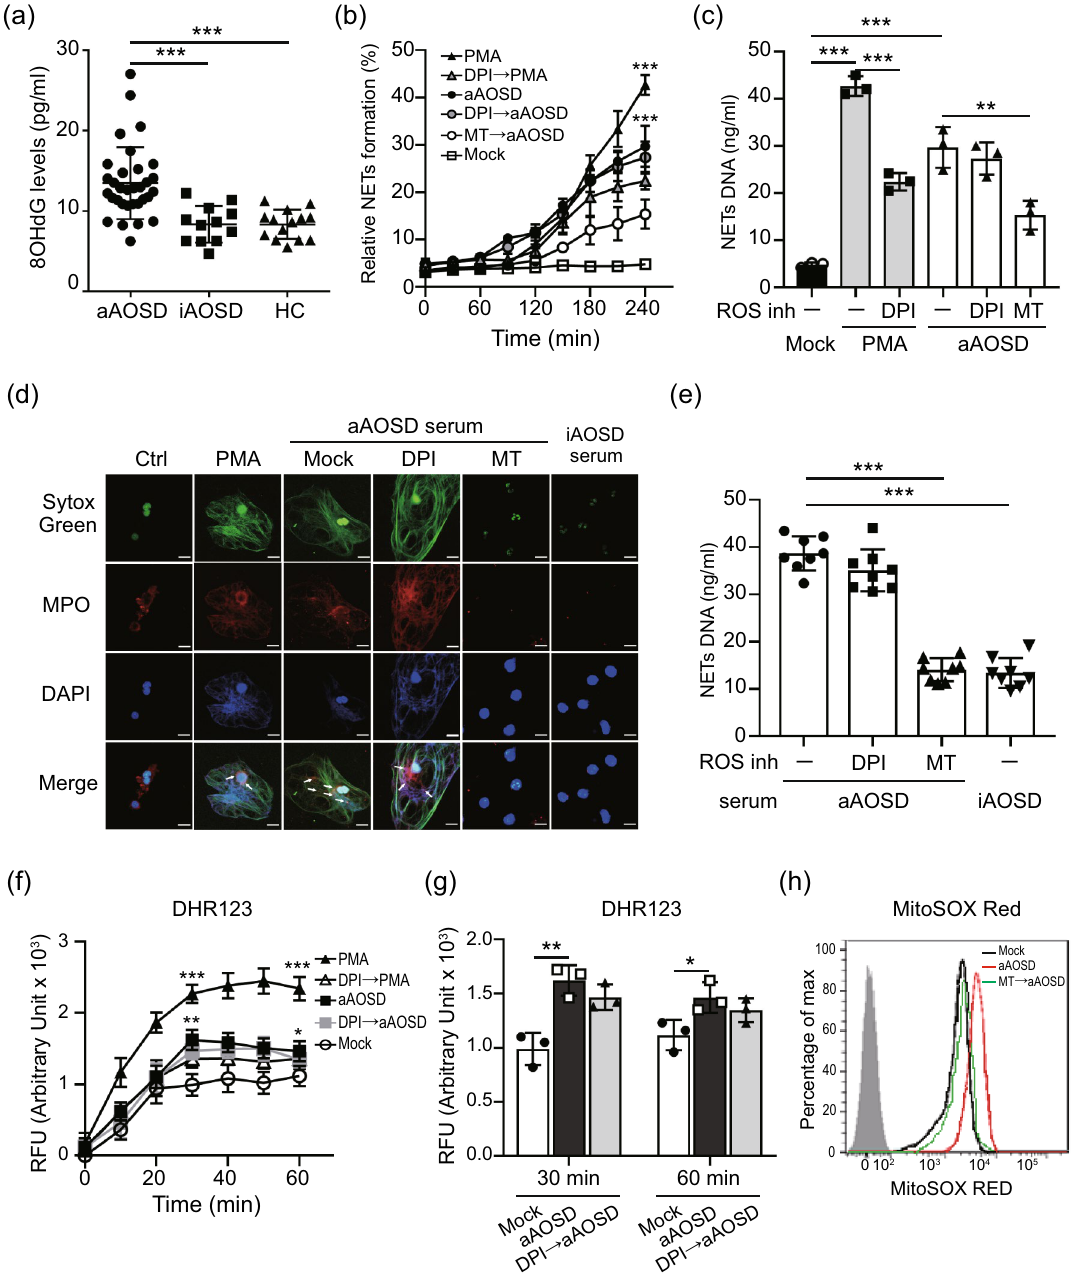
Figure 1. Increased levels of NETs was induced by sera of active AOSD patients is mitochondrial ROS- dependent. ( a ) Increased oxidative stress (8-OHdG) levels in active AOSD patients. ( b - d ) Normal human neutrophils were stimulated with PMA, or the serum of active AOSD (aAOSD) patient in the presence or absence of DPI (25 μM) or MitoTEMPO (10 μM). ( b ) The dynamic of NETs formation was analyzed by using Sytox Green with plate reader. The fluorescence readout obtained from cells lysed with 0.5% (vol/vol) Triton X-100 was considered as 100% DNA release, and the relative NETs formation was calculated at each time point. ( c ) The levels of NETs DNA release in the supernatant of cells at 4 h post-treatment was quantified using PicoGreen fluorescence dye with plate reader. ( d ) The NETs formation was detected by confocal microscopy. ( e ) Neutrophils were stimulated with serum of active AOSD (n = 8) or inactive AOSD (n = 8) patients in the presence of the indicated ROS inhibitor and the levels NETs DNA release were quantified. ( f , g ) The levels of cytosolic ROS were analyzed using DHR123 with plate reader. ( h ) The levels of mitochondrial ROS were analyzed using MitoSOX Red dye with flow cytometry. All experiments were performed in triplicate, and data are presented as the mean ± SD. ** P < 0.01, *** P < 0.001. Scale bars, 5